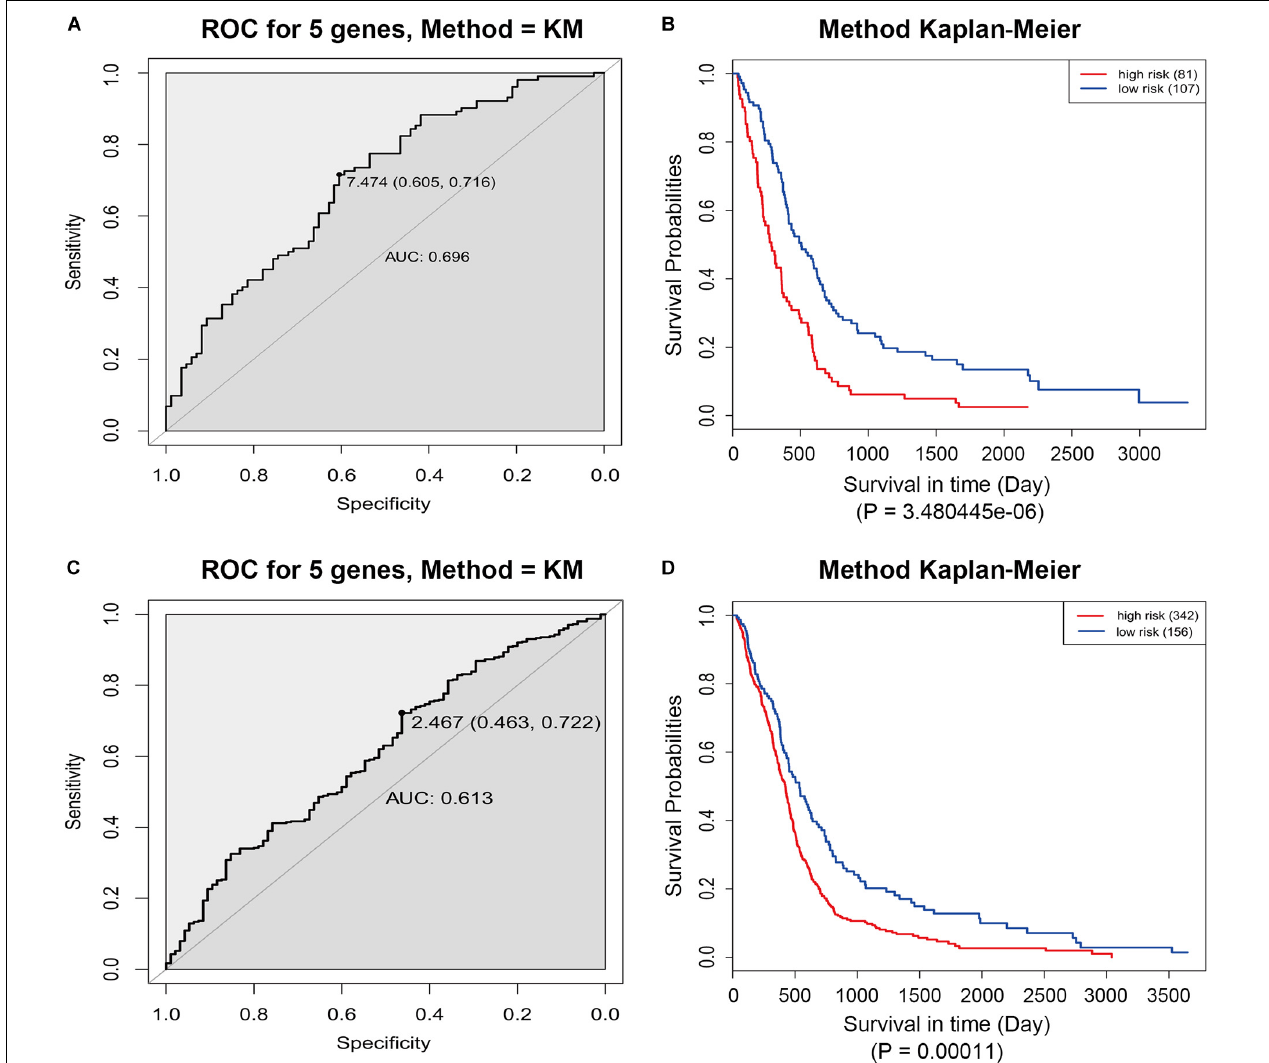
FIGURE 8 | ROC and Kaplan–Meier analyses of the five-gene signature in validation datasets. (A) ROC analysis of the GSE13041 dataset. (B) Kaplan–Meier analysis of the GSE13041 dataset. (C) ROC analysis of the TCGA microarray dataset. (D) Kaplan–Meier analysis of the TCGA microarray